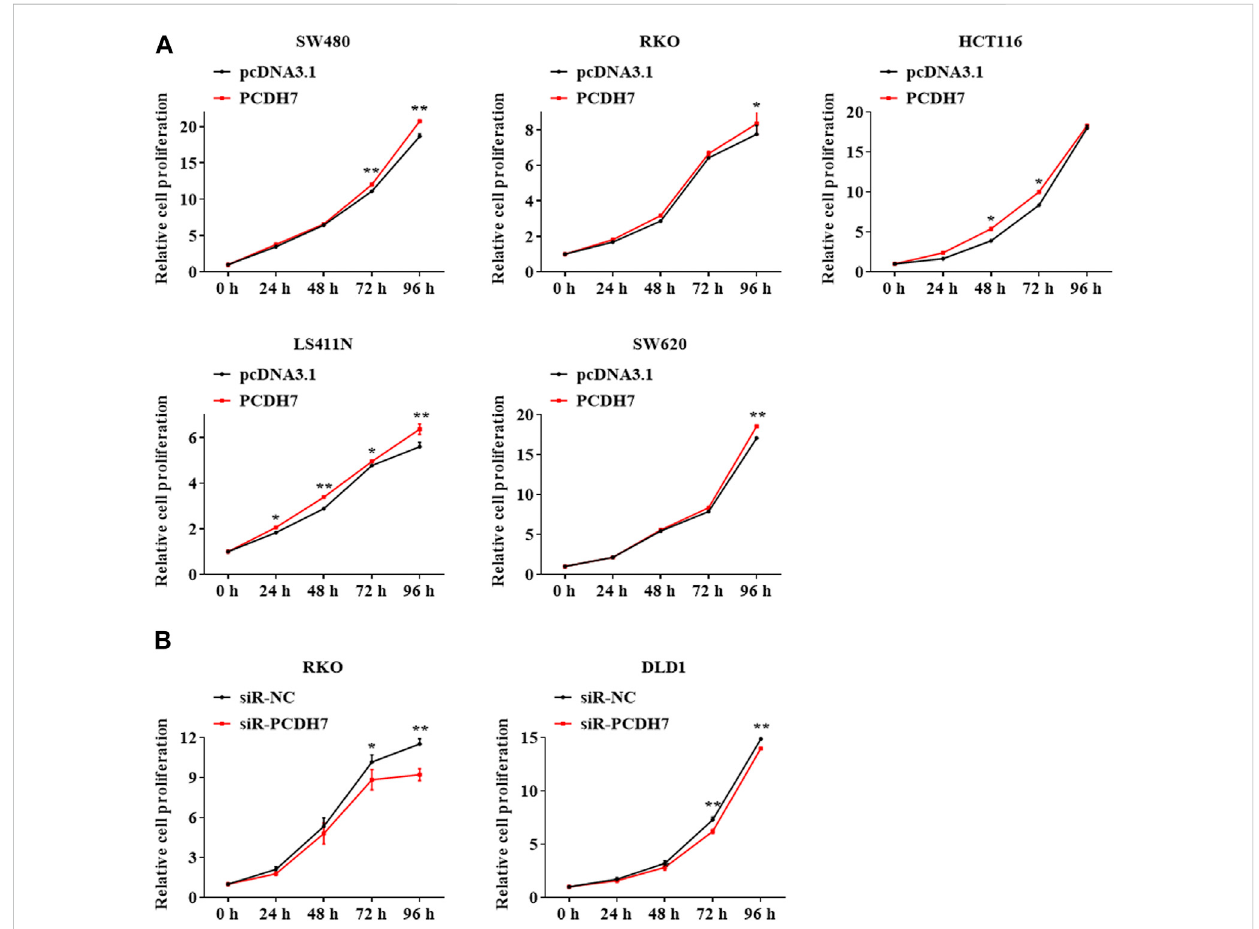
EffectsofPCDH7incoloncancercellproliferation. (A) MTTassayswereperformedtodetectthecellproliferationofSW480,HT29,HCT116,LS411N, and SW620 cells transfected with PCDH7 overexpression plasmid or empty vector pcDNA3.1 for 24 h. (B) Cell proliferation of RKO and DLD1 cells with PCDH7 silencing transfected with siRNA for 24 h was examined by MTT assays. Data are presented as mean ± SD for three separate experiments. ** p < 0.01 vs.